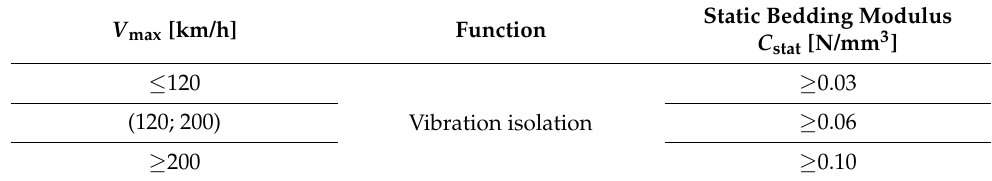
Table 4. Requirements for static bedding moduli of UBM according to SBB CFF FFS [1,36]. V max [km/h] Function